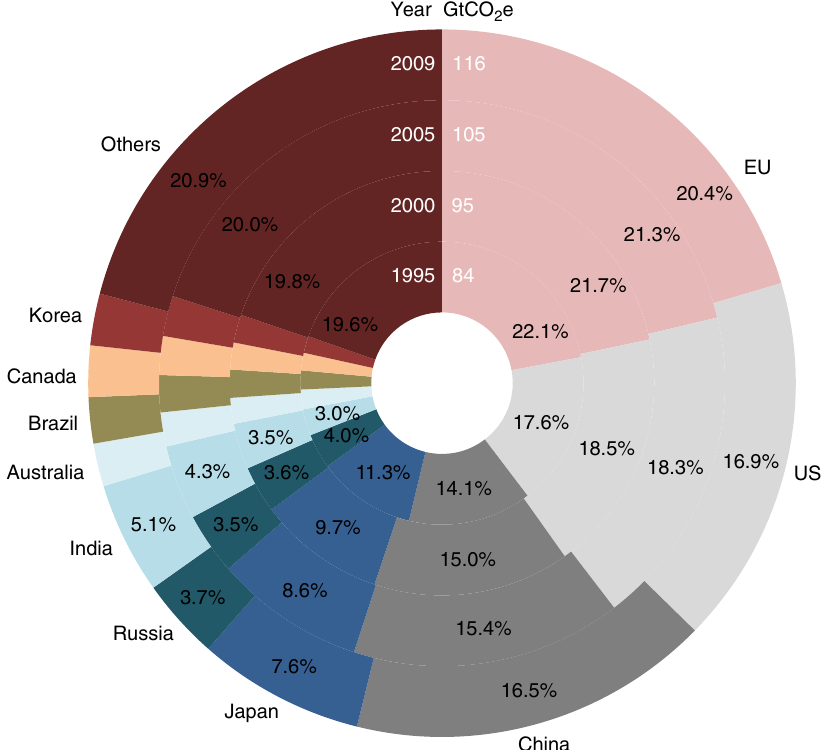
Fig. 5 Global emissions embodied in capital stock in 1995, 2000, 2005, and 2009. Others includes Indonesia, Mexico, Turkey, and rest of the world, see Supplementary Table 3. Absolute value in GtCO 2 e shown represents global